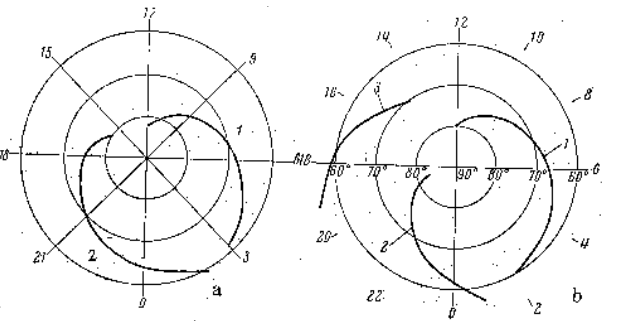
Figure 6. Dependencies of local geomagnetic time of Sa maxi- mum occurrence on corrected geomagnetic latitude for magneto- disturbed days. (a) – winter, (b) – summer; 1 – morning (M) maxi- mum of agitation; 2 – night (N) maximum of agitation; 3 – evening (E) maximum of agitation (Feldstein,